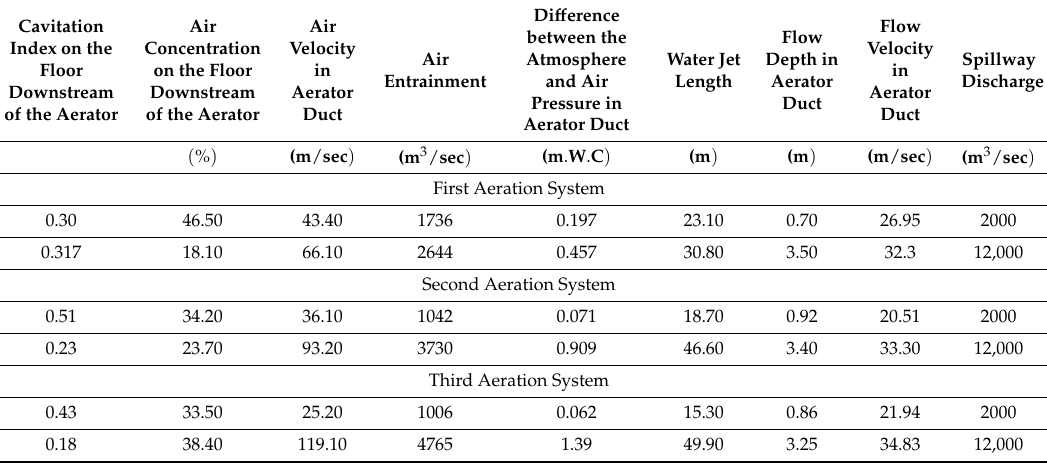
Table 6. Hydraulic parameters resulted from the 1 / 64 scale